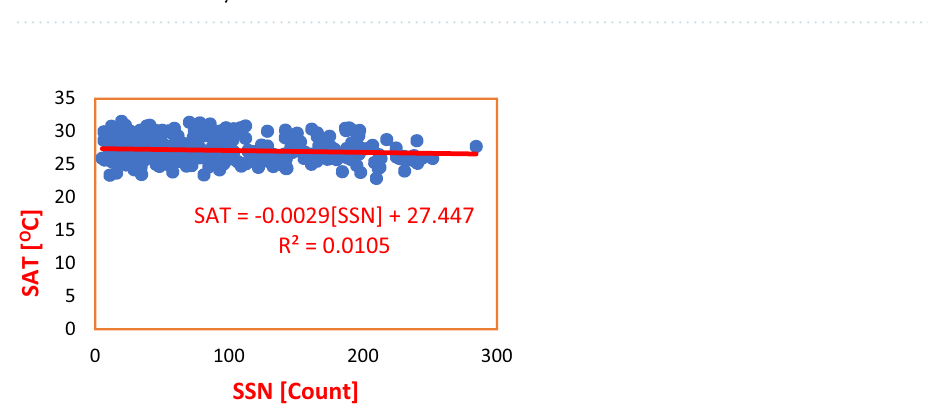
Table 2. List of solar cycles studied.